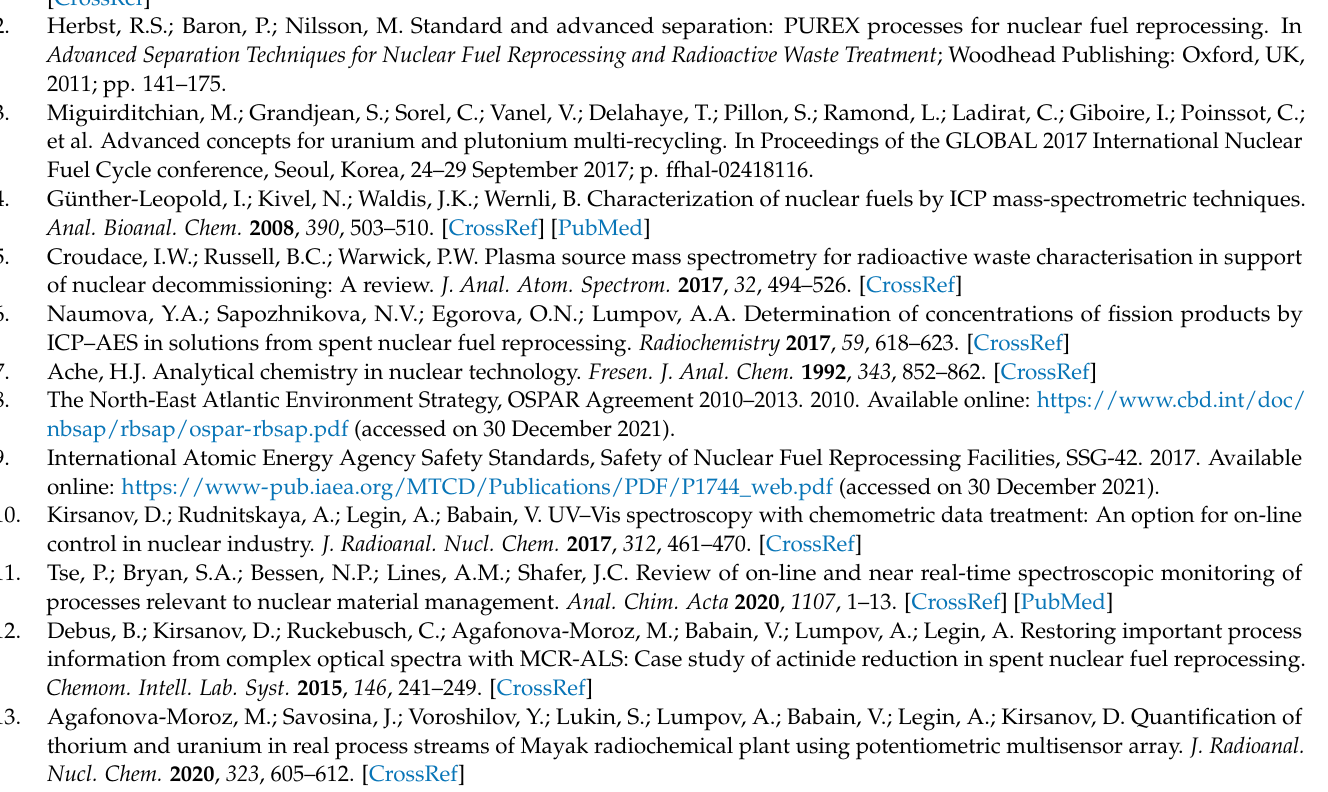
tion; Figure S1: Visual appearance of the multisensor system; Table S2: Elemental composition of the samples taken from the pilot extraction